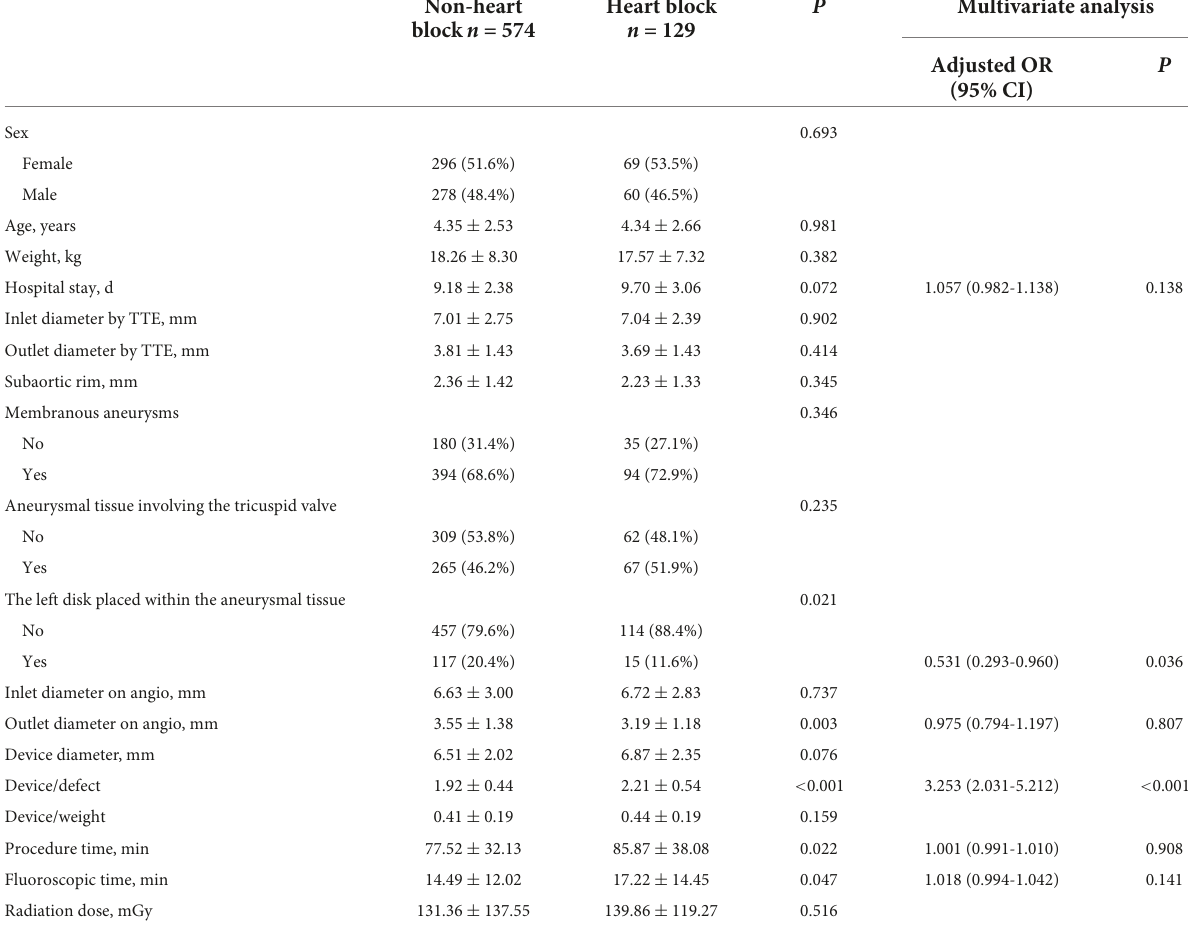
TABLE 6 Risk factors for occurrence of heart block in patients using symmetric